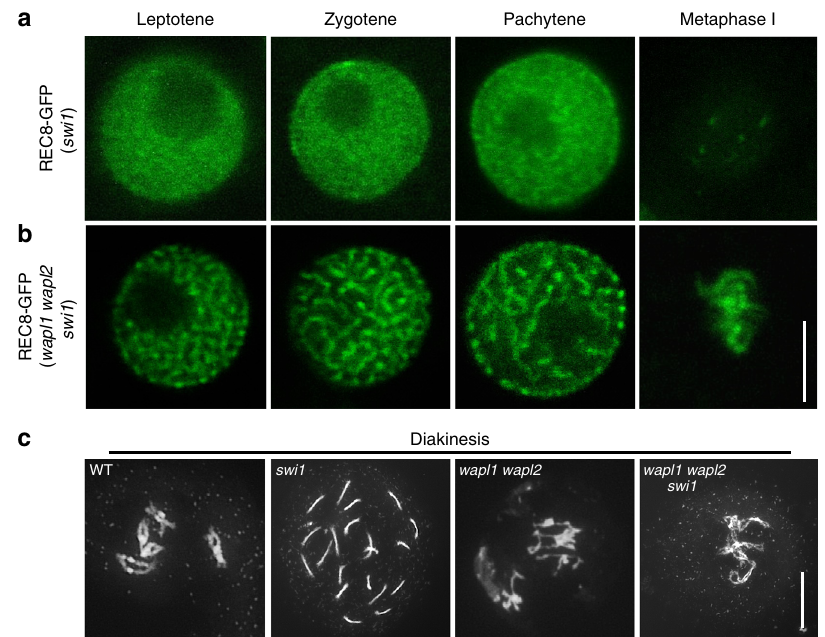
Fig. 5 SWI1 is dispensable for the sister chromatid cohesion in the absence of WAPL. a , b Confocal laser scanning micrographs of REC8-GFP localization in male meiocytes in swi1 ( a ) and in swi1 wapl1 wapl2 ( b ). Bar: 5 μ m. c Chromosome spreads of the wildtype (WT), swi1 , wapl1 wapl2 and swi1 wapl1 wapl2 mutants in diakinesis. Bar: 10 μ